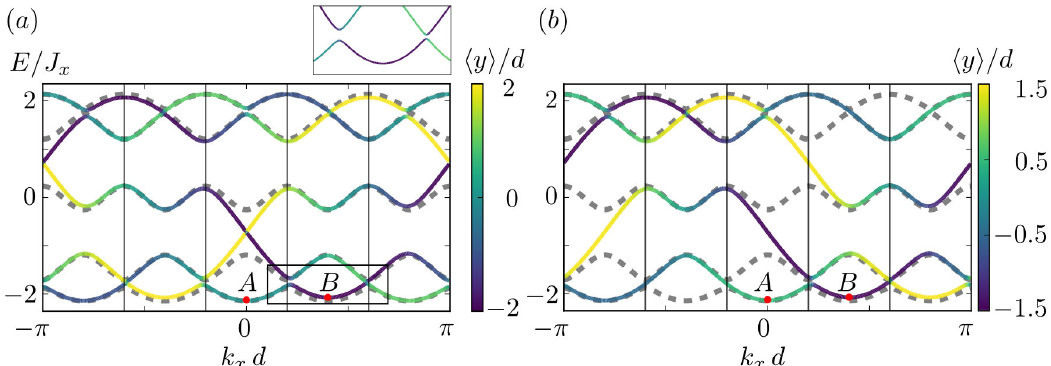
Figure 7: Spectrum of a Hofstadter strip with Φ = 4 π/ 5. The coloring of the lines indicate the mean eigenstates’ position along y for a system with N in panel (b). The dashed gray lines indicate in both cases the dispersion relation of a strip = 5 and periodic boundary conditions. The inset in panel (a) highlights a band gap with N y = π appearing at k , and a pair of well localized edge states crossing at k x 5 d dynamics described in the text, the momentum of the wave packet evolves from point A to B